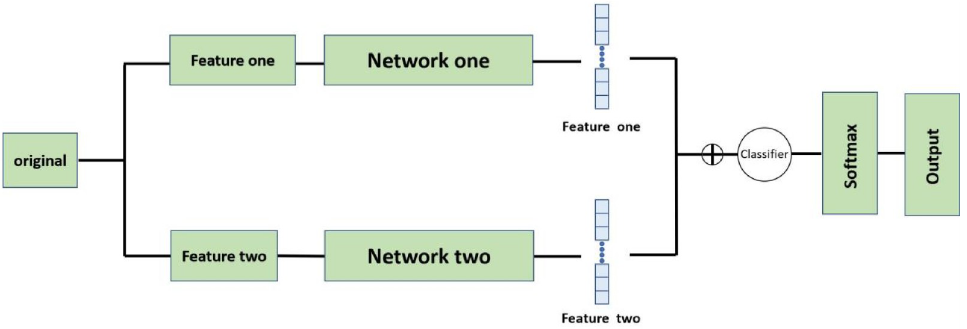
Fig 5. Improved fusion network architecture